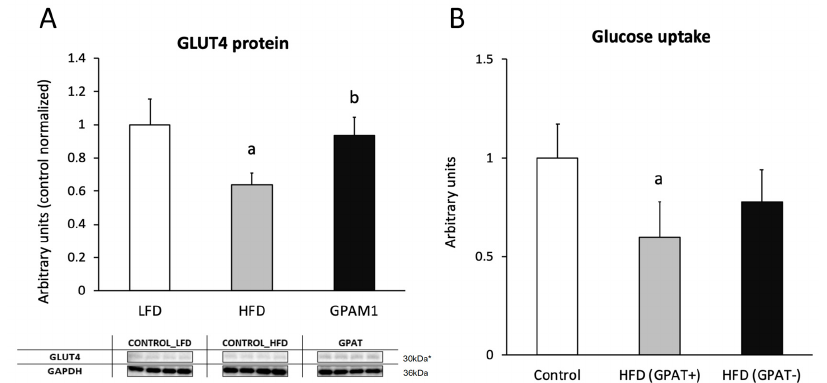
Figure 5. The impact of GPAT silencing on mouse gastrocnemious muscle insulin-stimulated glucose uptake. Panel A —protein expression of glucotransporter 4 (GLUT4); Panel B